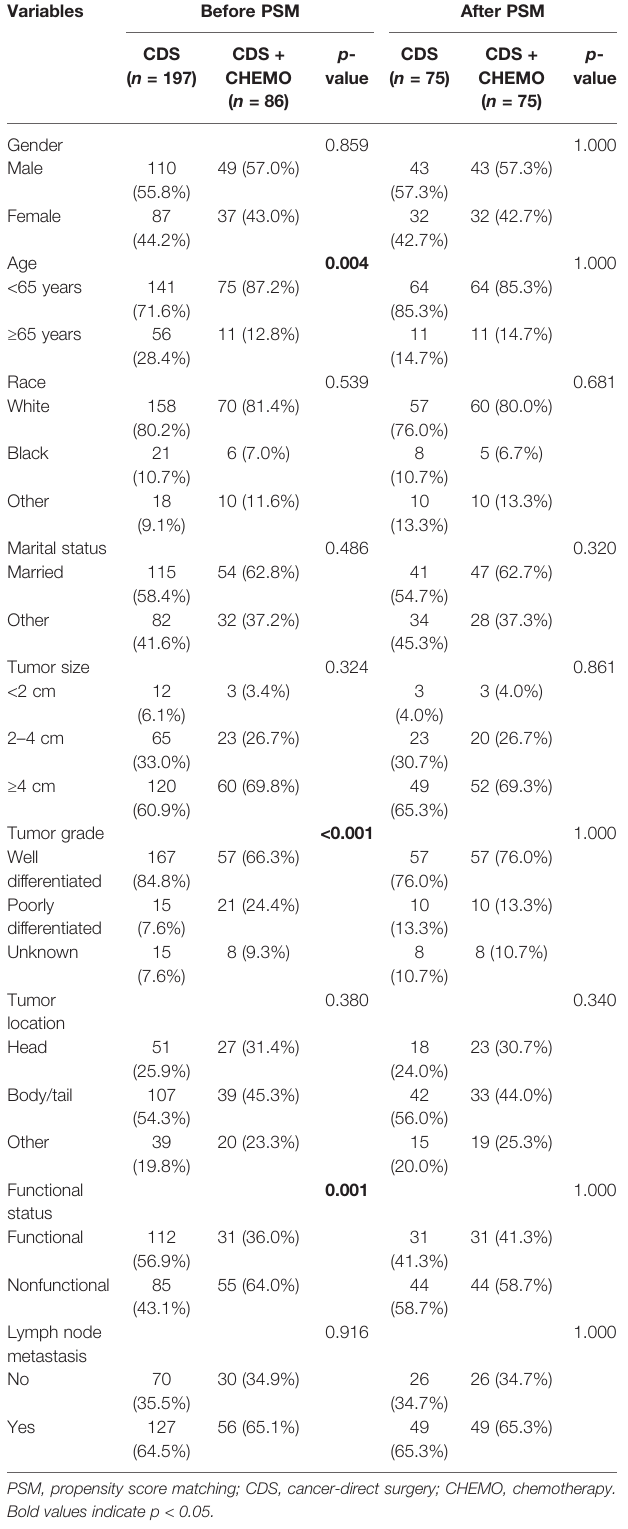
TABLE 5 | Comparison of baseline characteristics before and after propensity score matching. Variables Before PSM